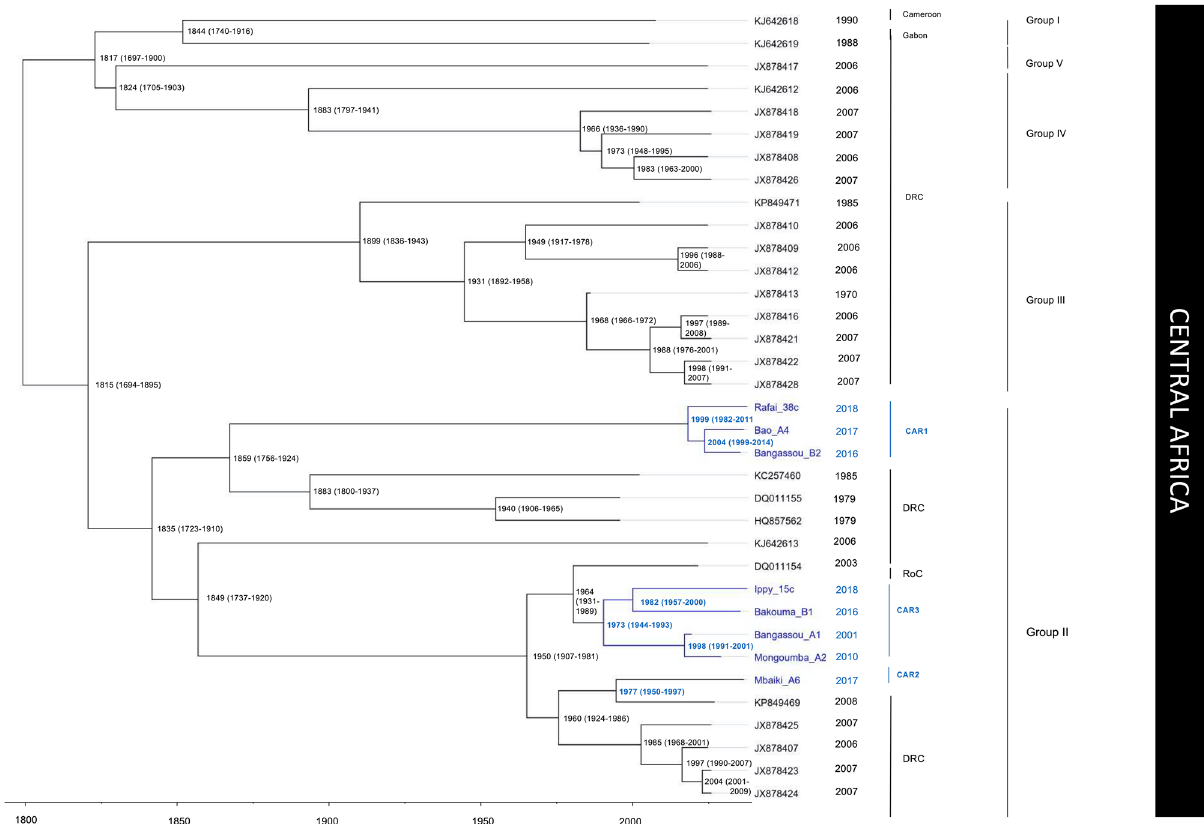
Figure 3. Bayesian chronogram of Central African monkeypox viruses (MPXVs). MPXV ge-nomes sampled between 2001 and 2018 in the Central African Republic are shown in blue. Median divergence times are indicated at the nodes and the 95% highest posterior density (HPD) is given in